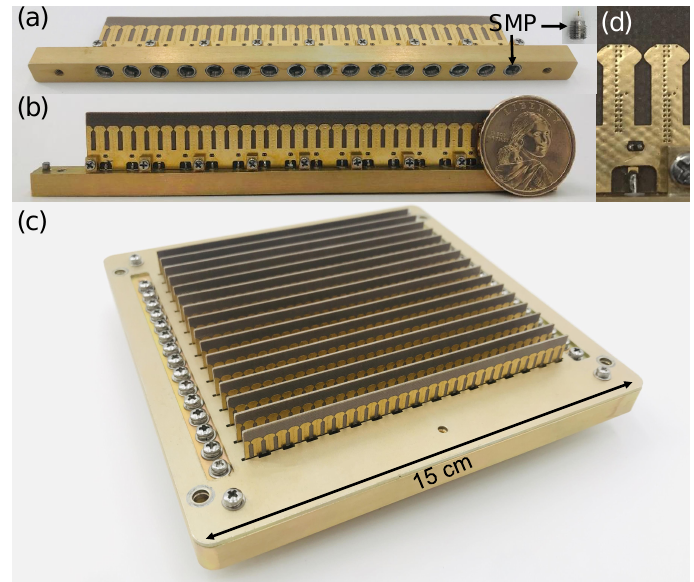
Figure 12. Fabricated 16 × 16 prototype and detailed illustrations for antenna elements. ( a ) Bottom view of a subarray; ( b ) Front view of a subarray; ( c ) 16 × 16 prototype; ( d ) Enlarged view of the